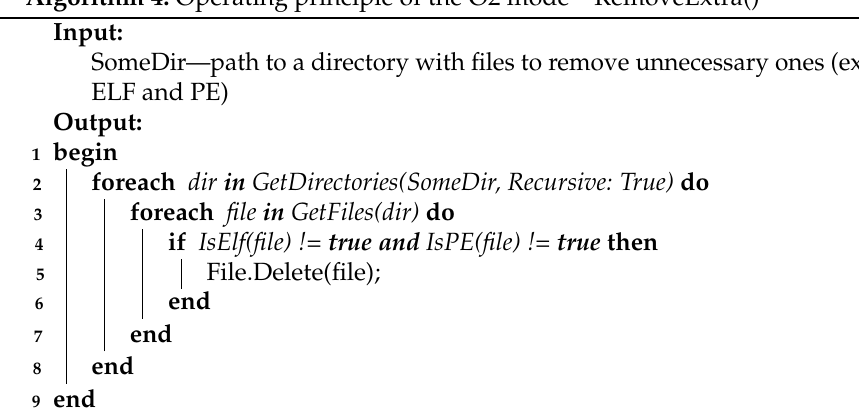
Algorithm 4: Operating principle of the O2